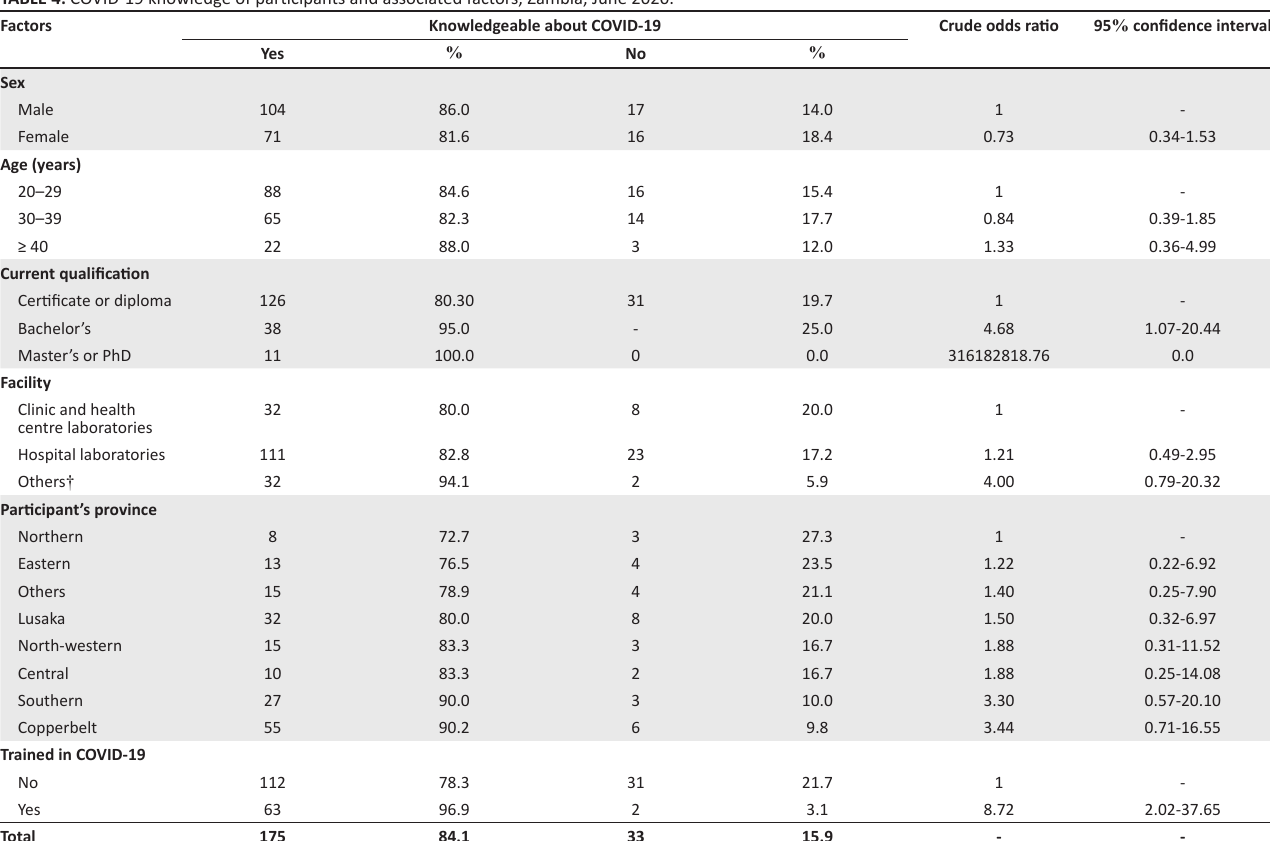
TABLE 4 : COVID-19 knowledge of participants and associated factors, Zambia, June 2020.